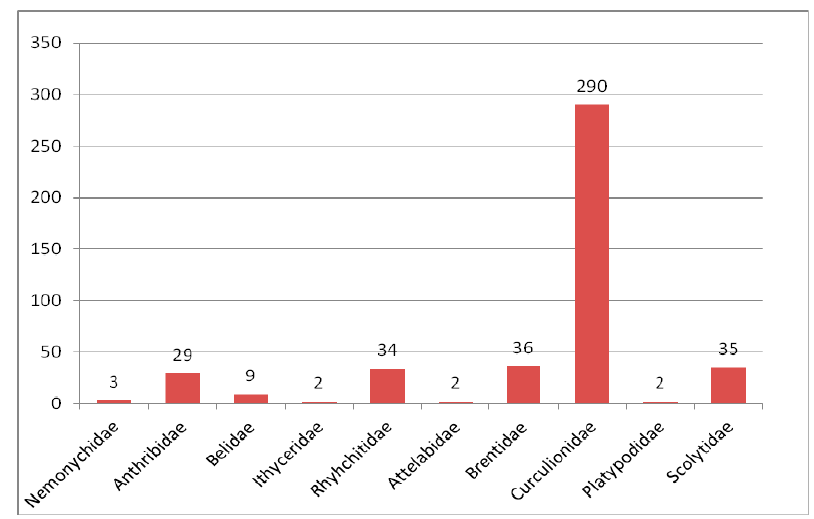
Figure 4. Composition of species of Curculionoidea in the Eocene fauna.